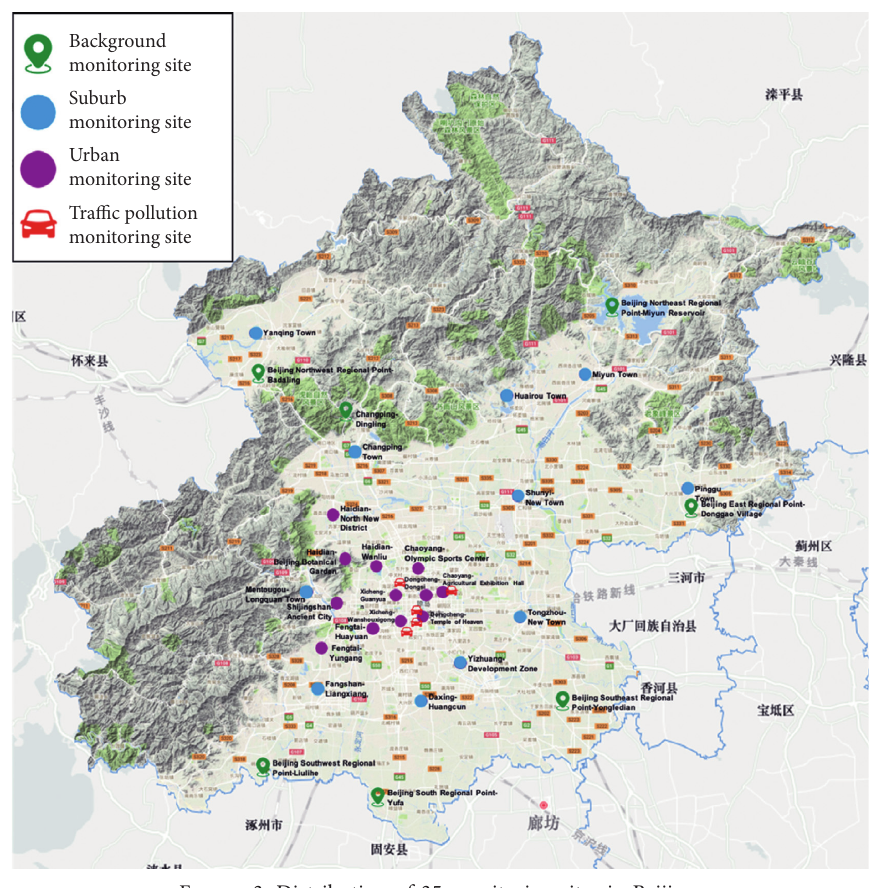
Figure 3: Distribution of 35 monitoring sites in